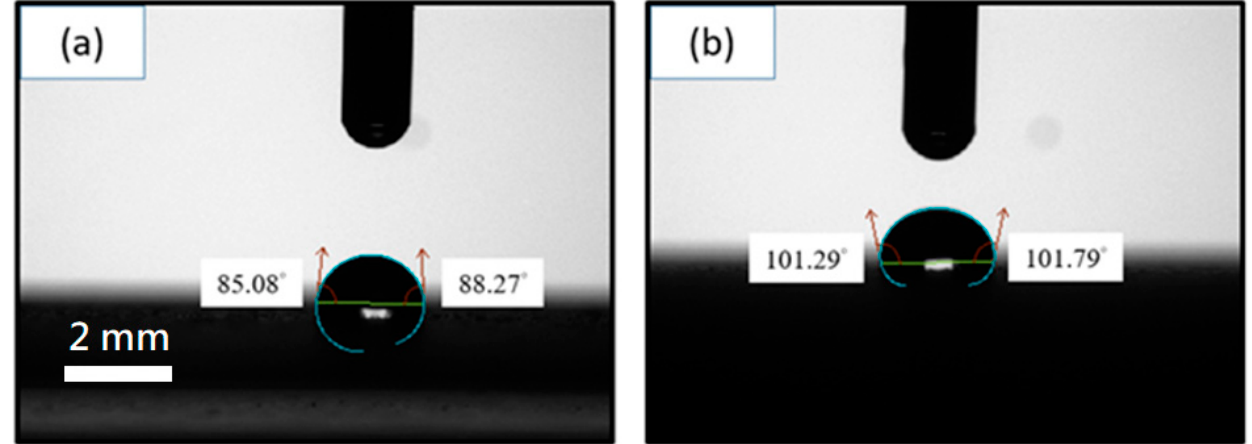
Figure 6. SEM images of the surface morphology for the coatings ( a ) without and ( b ) with GN fillers. ( c , d ) are the high- magnification images for ( a , b ), respectively.